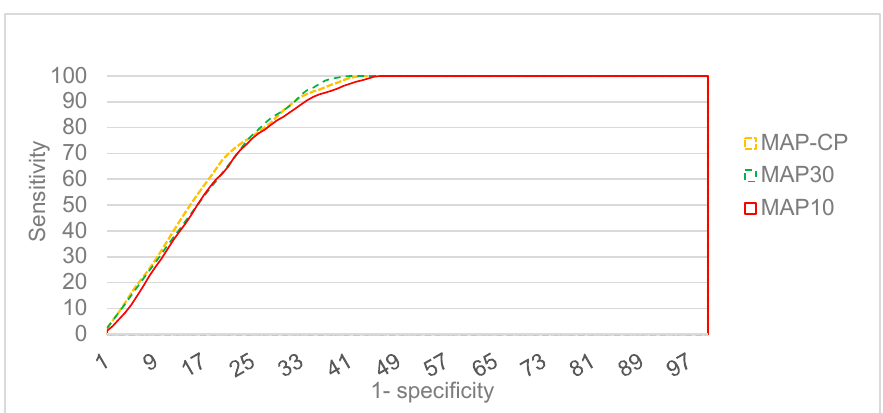
Figure 16. Area under the curve for evaluating the efficacy of the LSM by using past landslides.